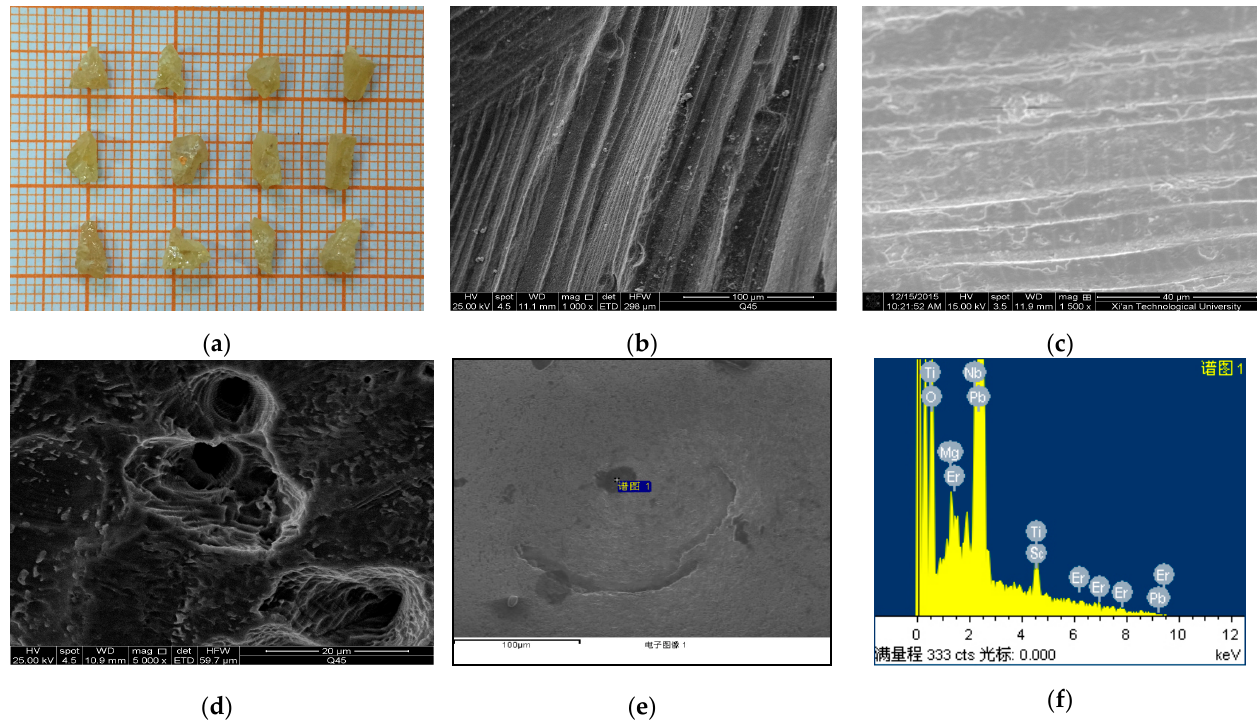
Figure 1. ( a ) Photograph of crystals PMN-32PT:Er 3+ /Sc 3+ ( b ) SEM image of PMN-32PT:Er 3+ /Sc 3+ ( c ) SEM image of undoped PMN-32PT ( d ) SEM image of corrosion pits in crystal PMN-32PT:Er 3+ /Sc 3+ (5000 × SEM morphology) ( e ) a location for EDS ( f ) EDS spectrum of a location on PMN-32PT:Er 3+ /Sc 3+ crystals